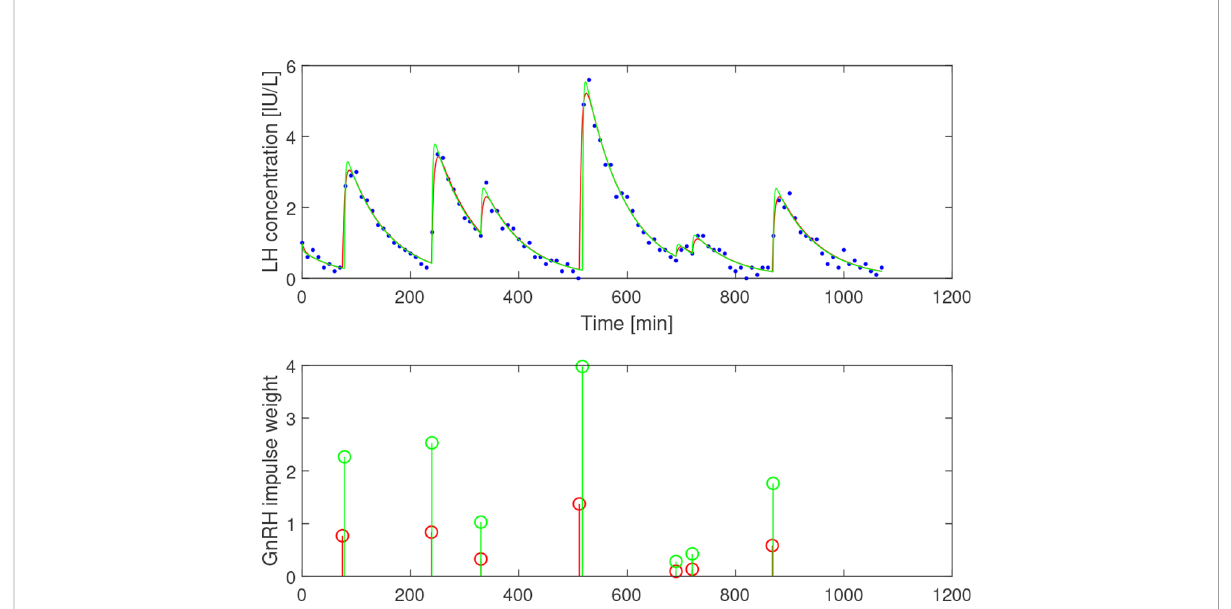
FIGURE 5 Estimation results assuming b 1 =0.23 (red) and b 1 =0.69 (green) based on LH data from a 23-year-old subject. Top: Simulated LH concentration and measured values (blue dots). Bottom: GnRH-impulses. b 1 mainly in fl uences the weights of the impulses, while the fi ring times are largely